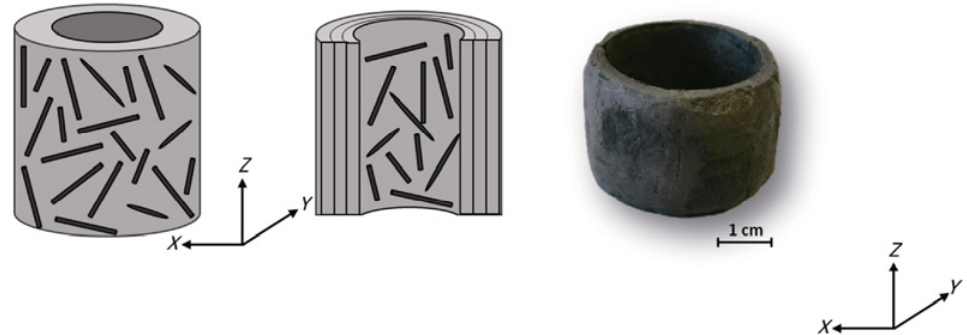
Fig. 14 Example of a green tubular sample obtained by overlapping layers around a